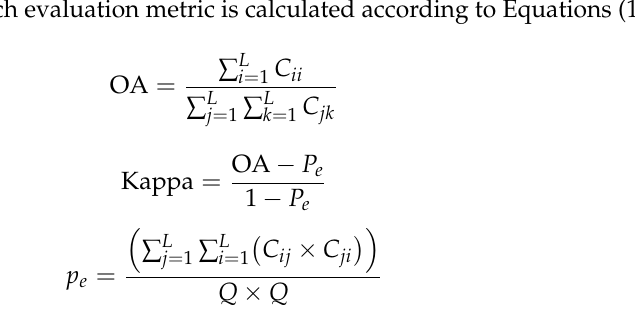
Predicted Positive Negative